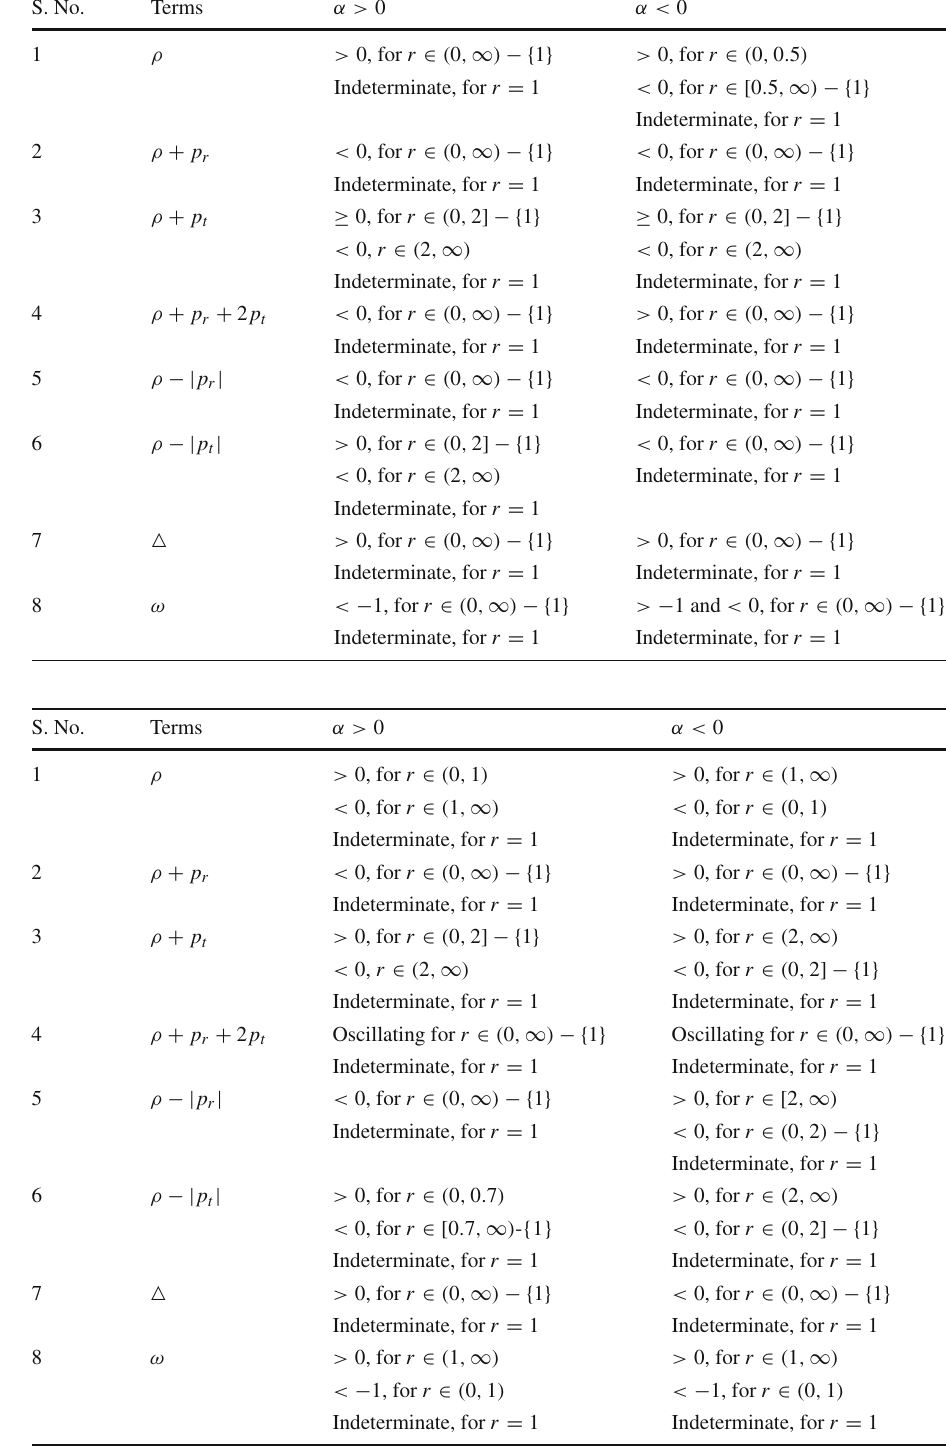
Table 2 Summary of results for φ( r ) = constant with n = 0